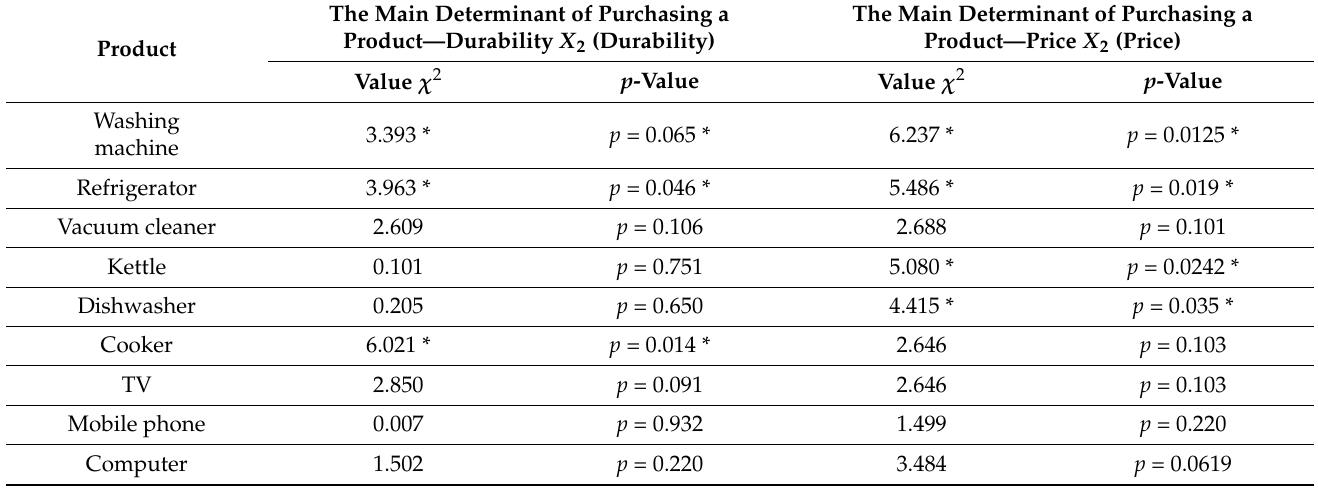
Table 7. The results of the chi-square independence test for the dependent variable, namely, perceiving the problem, and the variable regarding the choice of durability or price as a purchasing